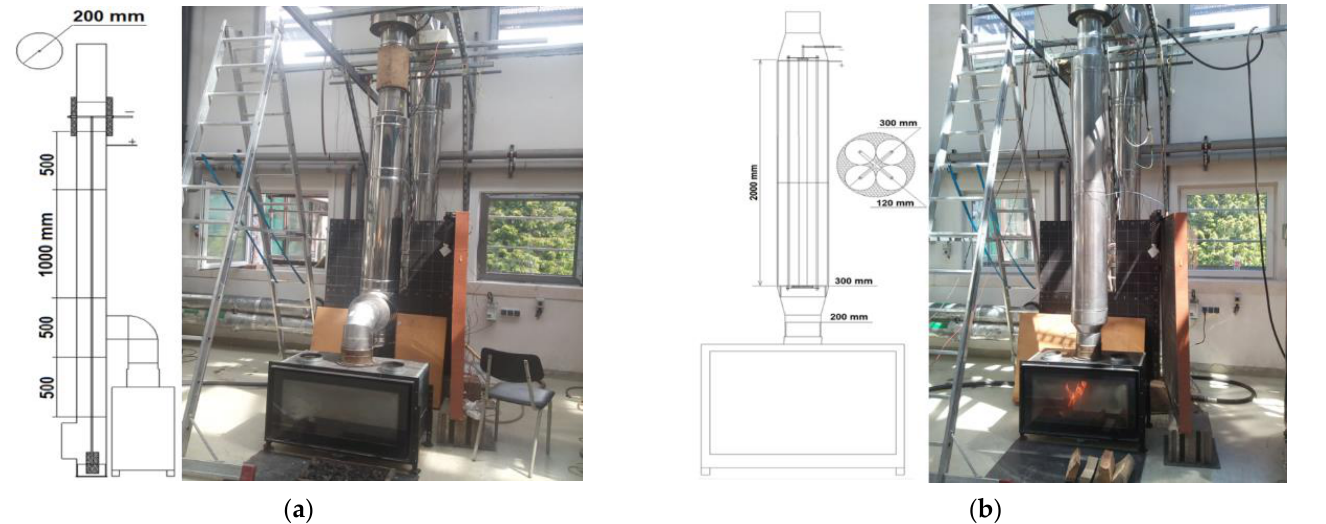
Figure 2. Experimental setup: ( a ) combustion device with standardized chimney electrostatic pre- cipitator; ( b ) improved four-pipe chimney electrostatic precipitator.